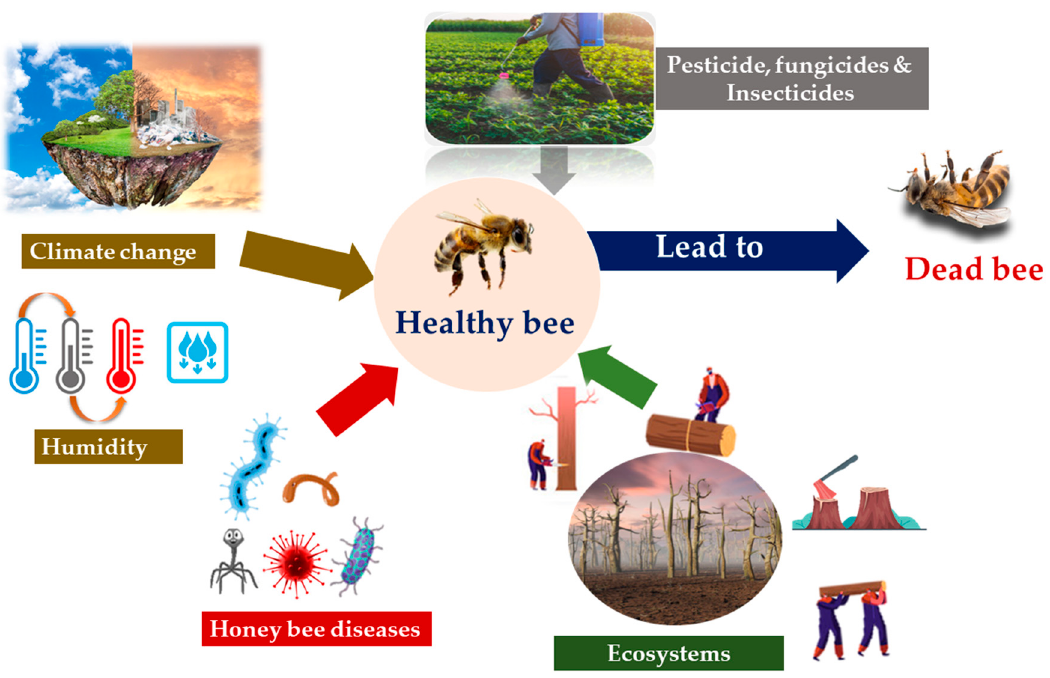
Figure 2. Challenges faced in bee pollination.